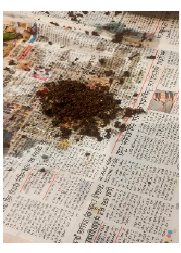
Figure 5. Representation of images in the real-world scenario. Table 5. No. of epochs with respect to training accuracy.